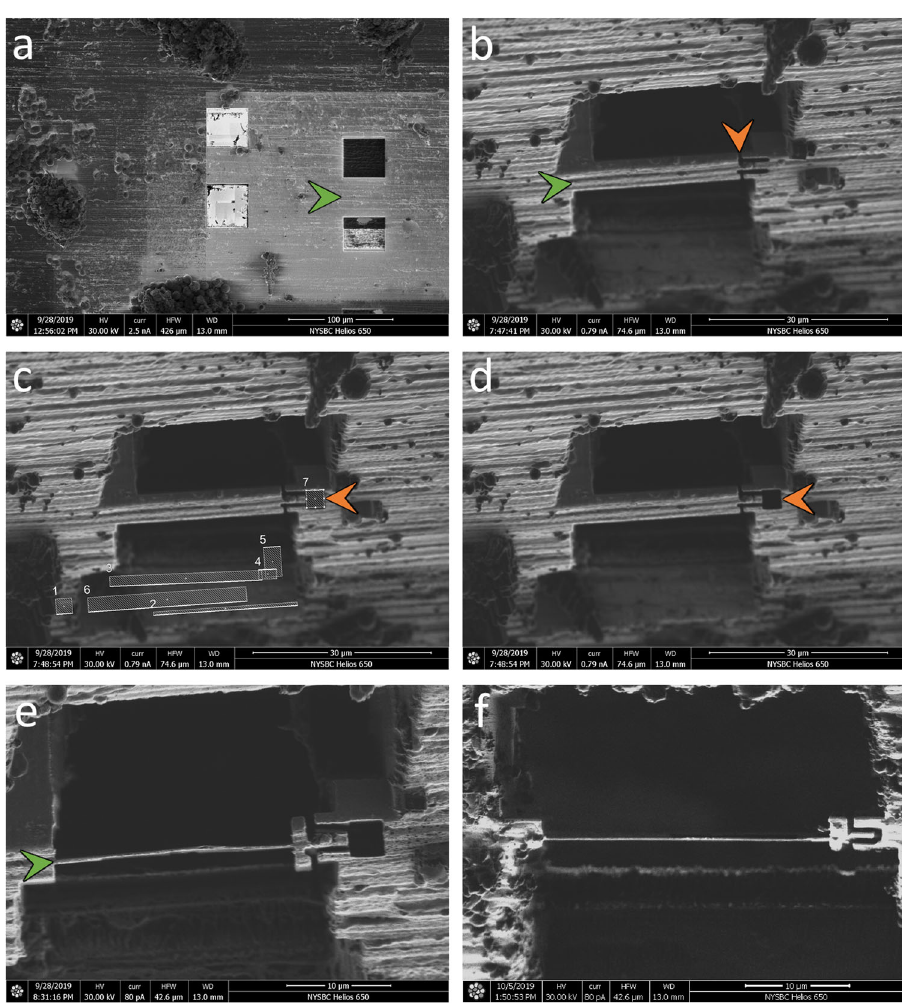
Fig. 2 FIB/SEM images of the notch milling work fl ow. After trench-milling a (green arrow), the resulting slab is coarsely milled down to <10 µ m thick b (green arrow). An initial, incomplete notch design is milled into one side of the slab, with a segment still connected b (orange arrow). This connection is then broken by milling, revealing a tab within a notch c , d (orange arrow). The lamella is then milled and polished as usual e (green arrow). A second example of a completed lamella with a notch mill is presented in f . To allow for freedom of movement (see Supplementary Fig. 8 and Supplementary Movie 9), each notch mill should separate the tab from the slab by 200 + nm. with similar